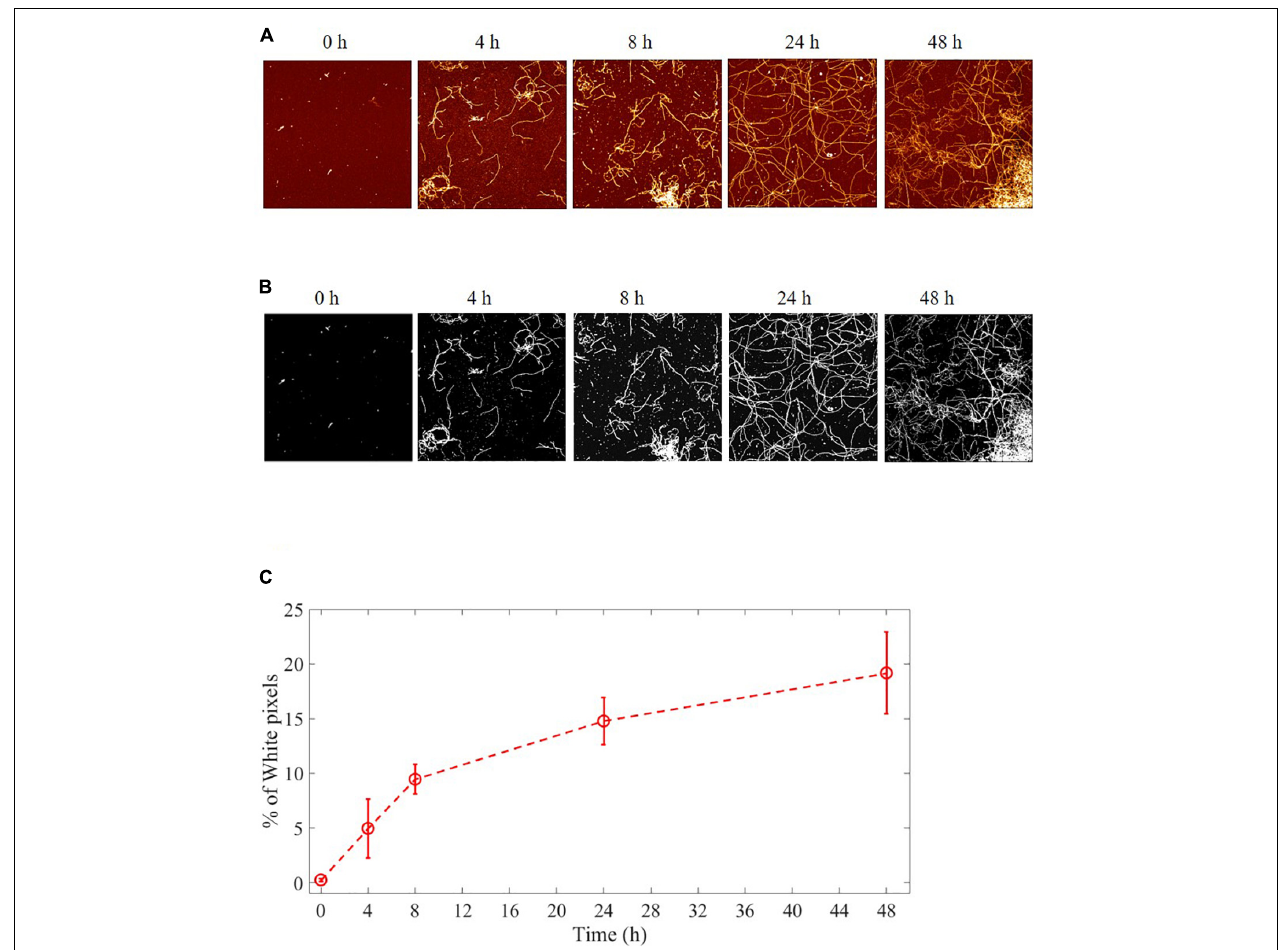
FIGURE 3 | Aggregation process of A β from monomers to fibrils studied by AFM. Representative images of A β at different fibrillation stages ( t = 0, 4, 8, 24, and 48 h) of incubation at 37 ◦ C. (A) AFM images: 4 µ m 2 × 4 µ m 2 , 1024 × 1024-pixel, Z-scale 10 nm. (B) A fixed height threshold (here 1.5 nm) is applied to the AFM images in order to quantify the number of pixels above this threshold, expressed in terms of percentage with respect the total number of pixels. The number of such pixels is proportional to the total length of the fibril i.e., to the sum of the lengths of all the deposited fibrils. In this way, it is possible to quantify the fibril growth. (C) Quantification of the fibrillation. Percentage of pixel above a height threshold (1.5 nm) as obtained from AFM images, plotted as a function of the incubation time at 37 ◦